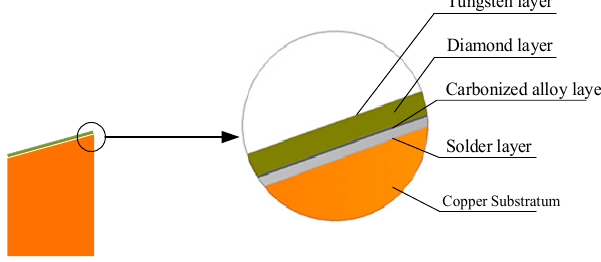
Figure 1. Structural diagram of the X-ray composite anode.